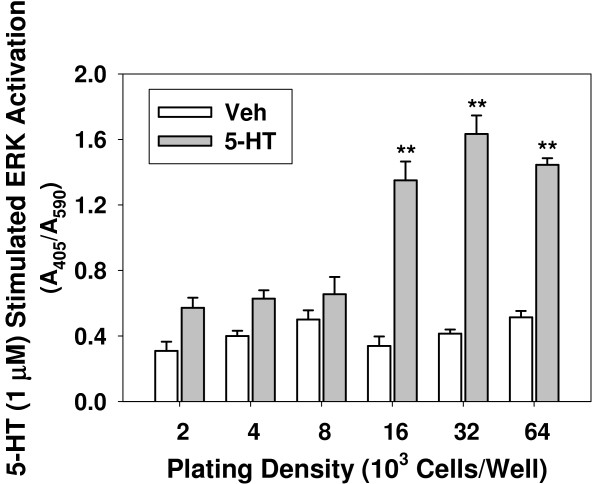
Effect of plating density on ERK activation in 5-HT2CR-CHO cells. Cells plated at the indicated densities for 24 hrs were preincubated overnight in serum-free medium, and stimulated with vehicle (Veh, open bars) or 1 μM 5-HT (gray bars) for 5 min. Levels of pERK were determined by plate immunoassay and normalized to cell number by crystal violet staining. Background (control wells without primary antibody) value was subtracted. Graph is representative of three independent experiments. n = 8; ** p < 0.01 vs. vehicle.